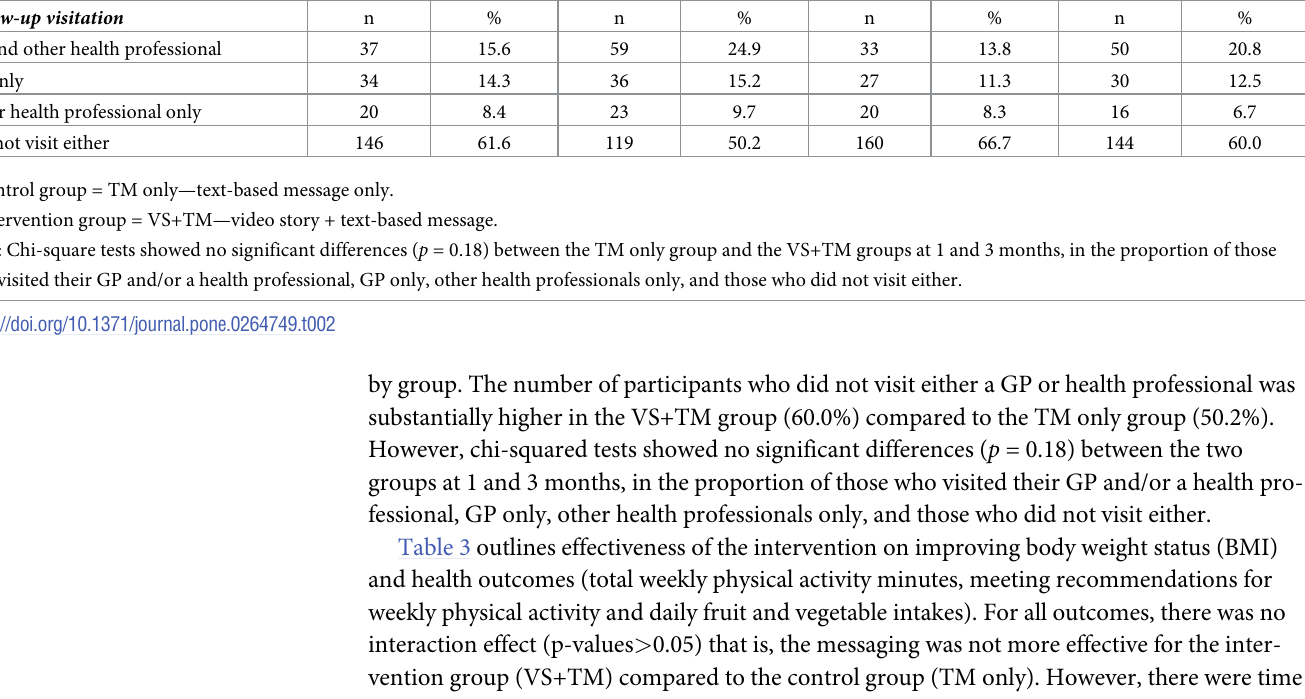
Follow-up visitation